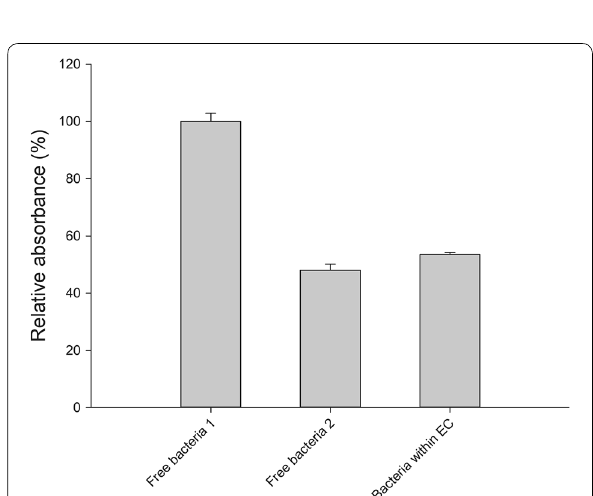
Fig. 3 Fluorescein diacetate assay (FDA) of expanded clay-immobilized bacteria. Extent of microbial enzyme activity were measured with free bacteria 1 (1.0 10 7 cell/mL), free bacteria 2 × (1.0 10 6 cell/mL), and EC-immobilized bacteria submerged into × bacteria solution of 1.0 10 8 cell/mL. Relative absorbance (%) × were calculated by comparison to absorbance of free bacteria 1 (1.0 10 7 ×